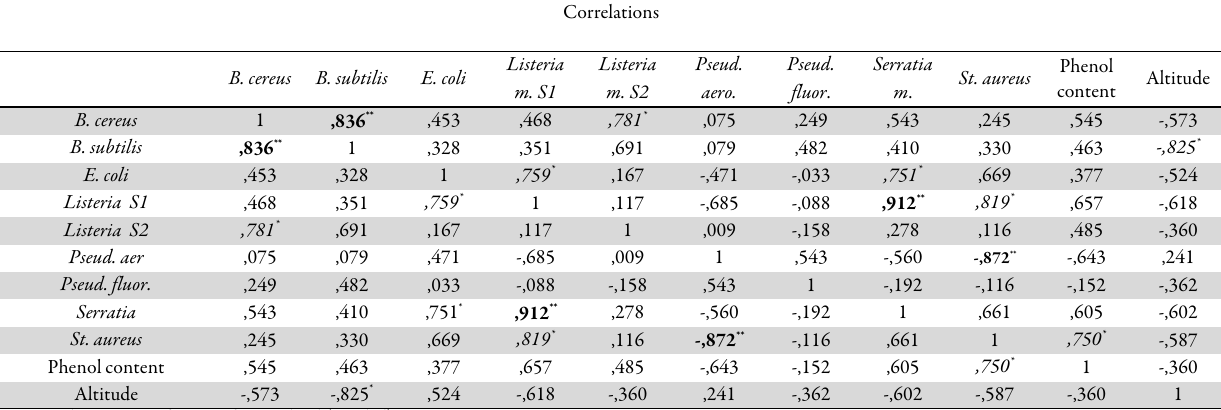
Table 5. Correlation between each lingonberry sample obtained data: antimicrobial effect on different bacteria, phenol content and altitude; strong correlation is presented in bold, significant values in